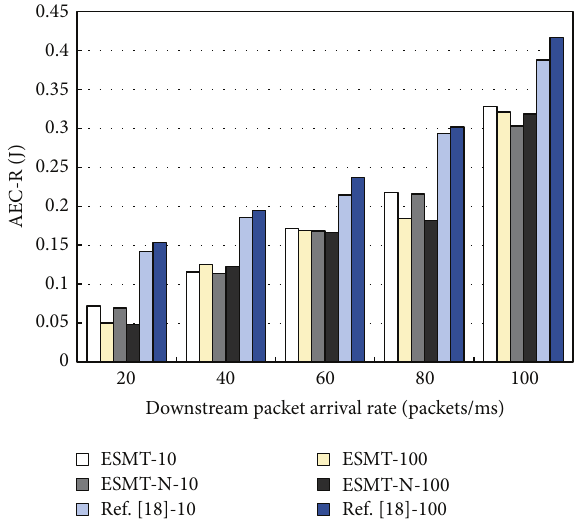
AEC of both ESMT and ESMT-N does not always increase.